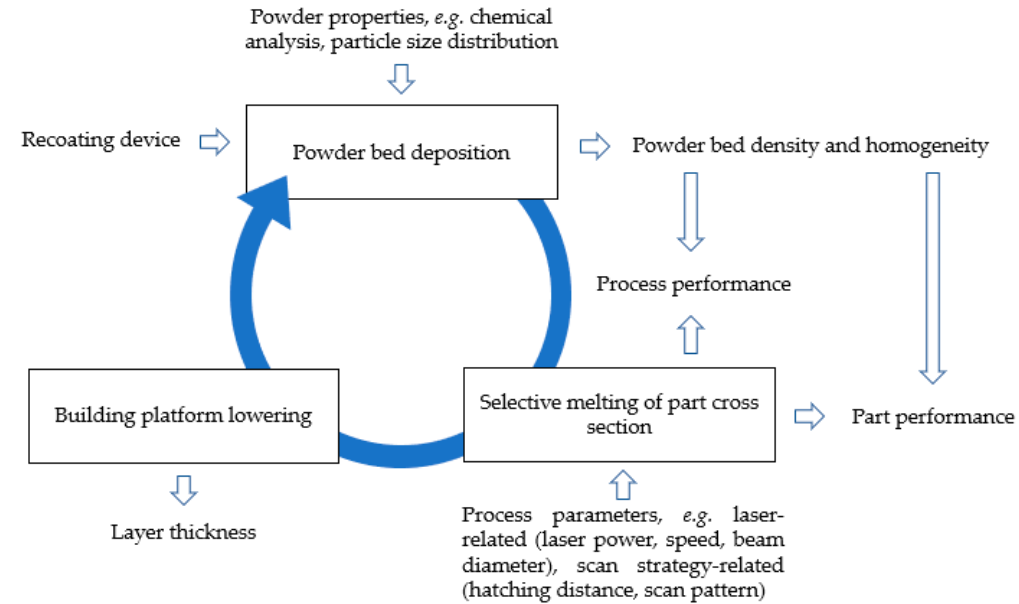
Figure 2. Main factors influencing process and part performances, and their inter-correlation.